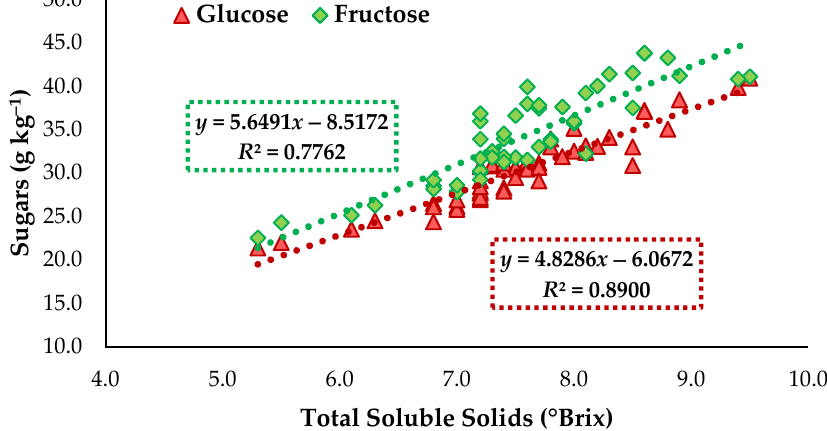
Figure 2. Quadratic correlation between: Sugars (glucose and fructose) and total soluble solids (TSS). Four repetitions per treatment were used for the correlation.